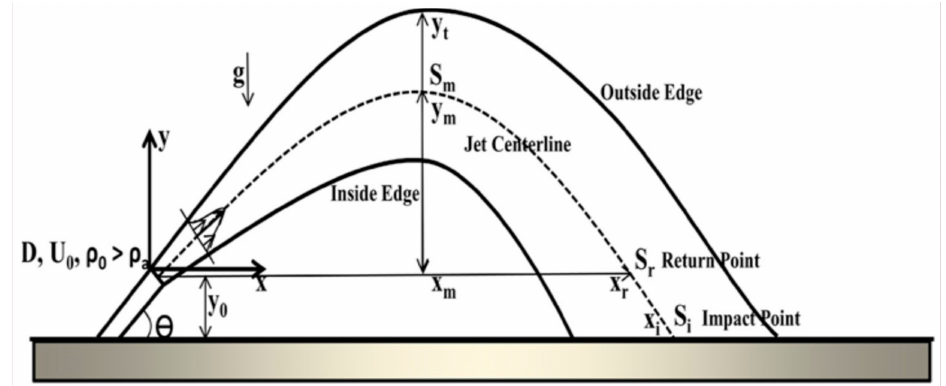
Figure 1. Configuration for Negatively Buoyant Jet (Reprinted with permission from Ref. [16]. Copyright 2022 Springer